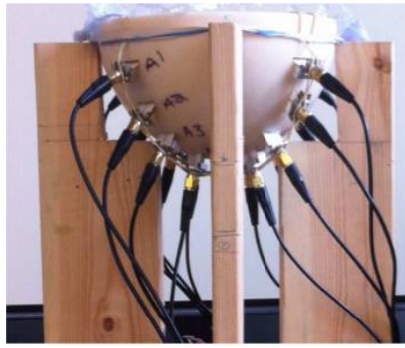
Figure 22. A schematic diagram representing the system developed by Porter et al. [80]. Reprinted with permission from [80].